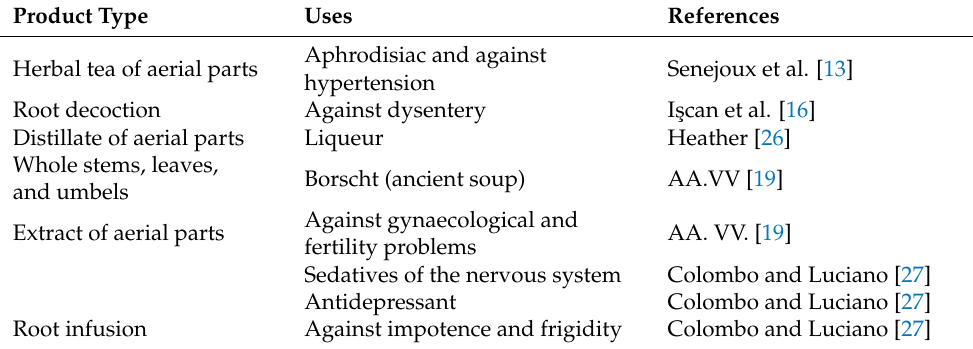
Table 2. Literature regarding the ethnobotanical uses of H. sphondylium